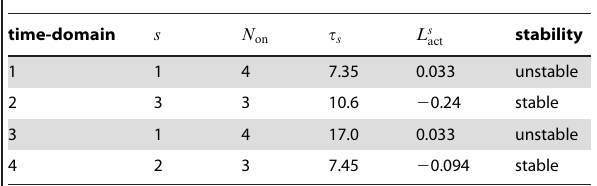
Table 1. Domain properties.